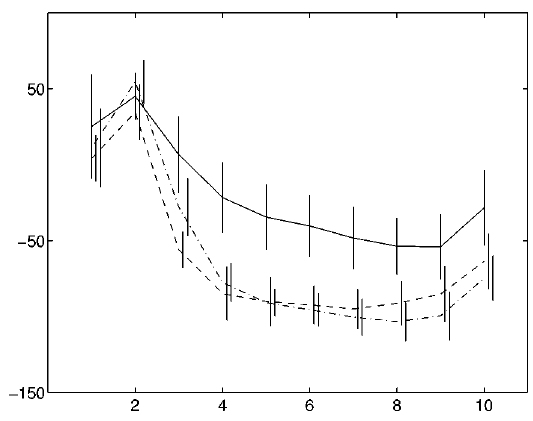
Fig. 10. Average estimated Gray Level Coocurrence Matrix feature, Shade, for samples from the normal+regenerating (- -), noduli (- (cid:1) ) and tumour (—) classes, are plotted versus segment. The standard deviation of the feature for each class and segment is indicated. This is based on the mean feature values obtained for each sample in each class.